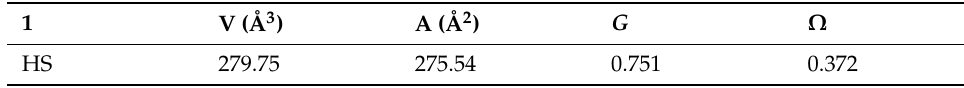
Table 2. Details of the HS generated for 1